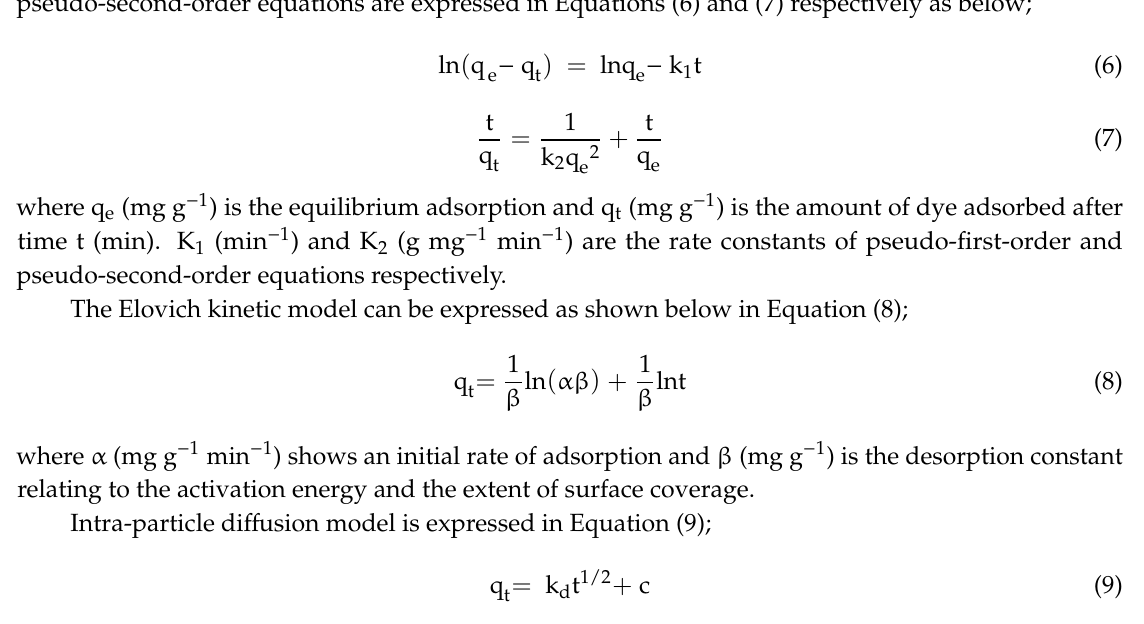
Figure 10. Effect of adsorbent dosage on adsorption of AB40 onto Fe 3 O 4 , PANI and PANI/Fe 3 O 4